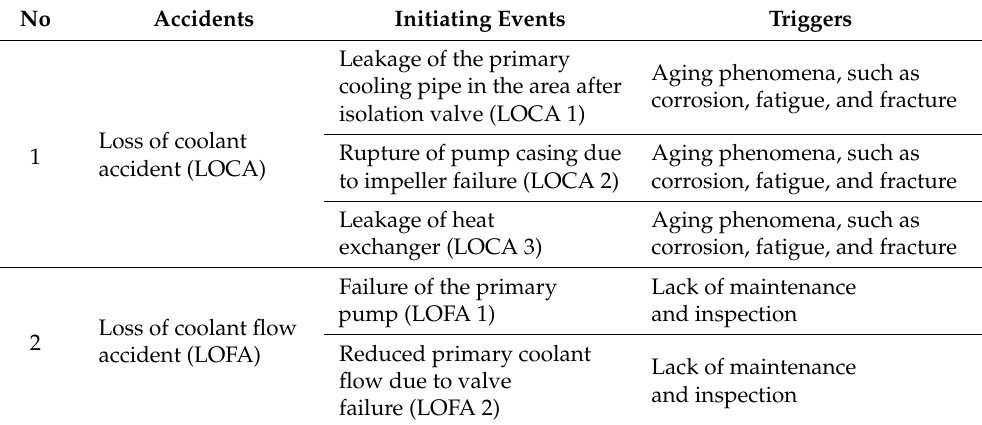
Table 7. Internal initial events of the RSG-GAS primary cooling system [34].